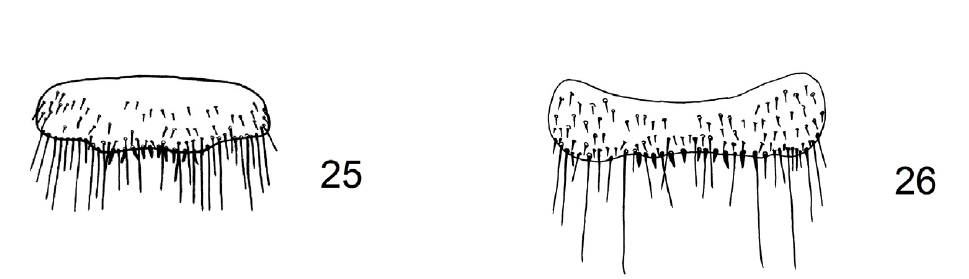
Figure 3. ( 21 ) Nycteribia ( Acrocholidia ) vexata Westwood, 1835, male, sternite 5; ( 22 ) Nycteribia ( Acro- cholidia ) vexata Westwood, 1835, female, abdomen, genital plate; ( 23 ) Nycteribia ( Nycteribia ) schmidlii Schiner, 1853, male, sternite 5; ( 24 ) Nycteribia ( Nycteribia ) latreillii (Leach, 1817), male, sternite 5; ( 25 ) Nycteribia ( Nycteribia ) pedicularia Latreille, 1805, male, sternite 5; ( 26 ) Nycteribia ( Nycteribia ) kolenatii Theodor and Moscona, 1954, male, sternite 5.